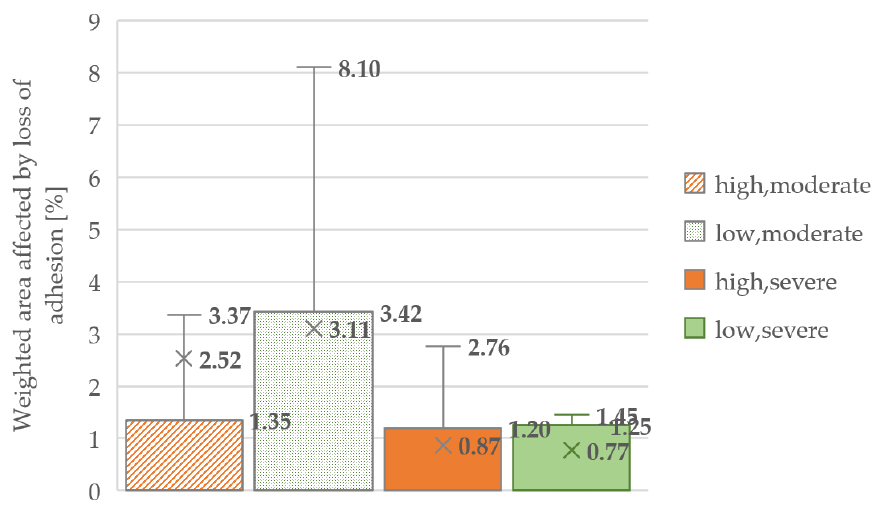
Figure 7. Boxplots of the weighted area of the façade affected by loss of adhesion anomalies according to the buildings’ height and exposure to wind–rain action.